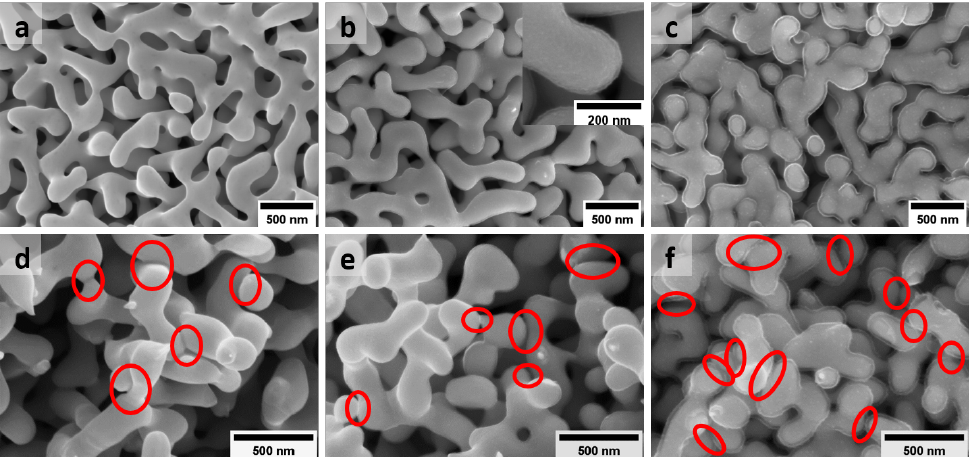
Figure 1. SEM images showing the typical microstructure of as-prepared ( a ) bare NPG (with mean ligament size of L = 150 ± 40 nm) and NPG/PPy hybrid materials with ( b ) the thinnest ( t PPy = 11 ± 2 nm) and ( c ) the thickest ( t PPy = 29 ± 3 nm) PPy layer. The inset in ( b ) illustrates one representative NPG/PPy strut at a higher mignification where PPy coating is clearly seen on NPG ligament. ( d – f ) Microstructure of NPG, NPG/PPy(10 nm), and NPG/PPy(30 nm) after deformation of 15%, respectively. The red ellipses indicate the “bridging” of neighboring